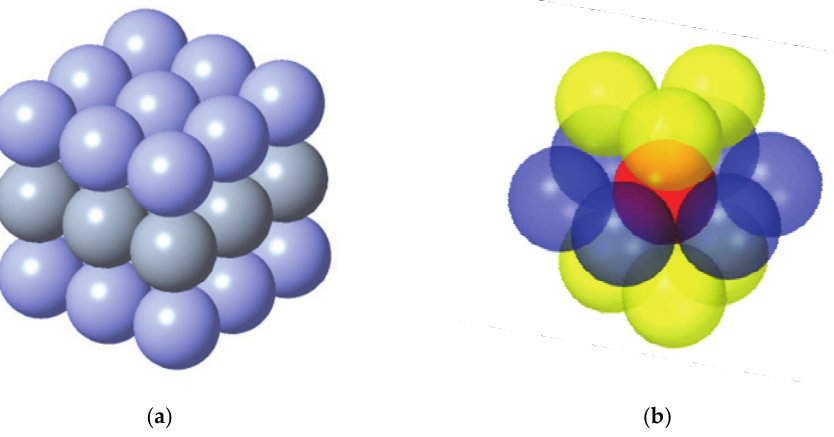
Figure 2. Particle arrangement: ( a ) simple cubic and ( b ) hexagonal